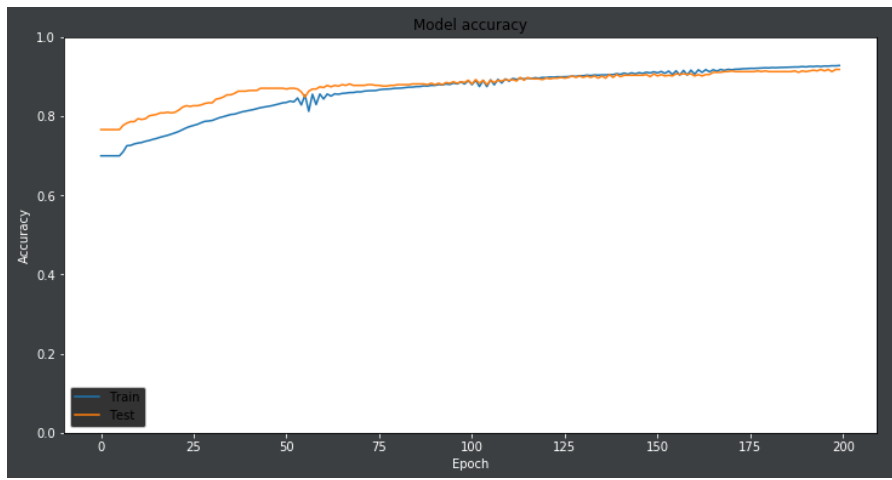
15 of 23 Table 8. LSTM, LSTM-AR, and MLP models: AUC, accuracy and loss results by considering the dataset found in reference [40]. Testing Samples LSTM (20%) LSTM-AR (20%) MLP (20%) AUC %